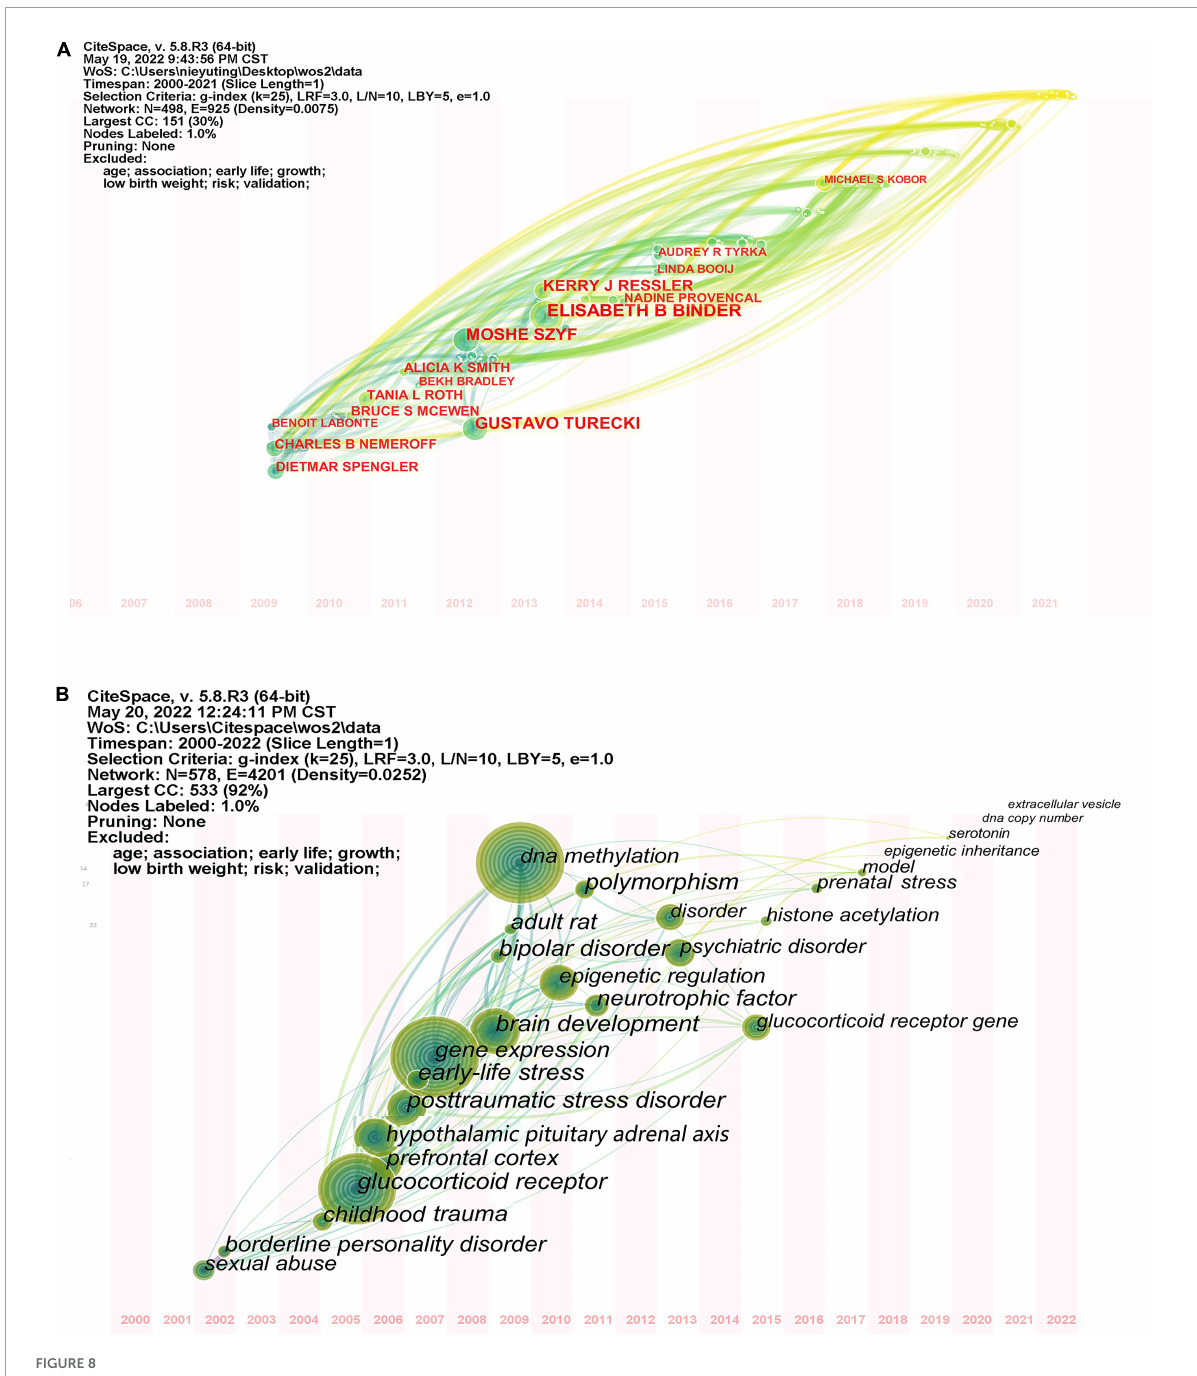
FIGURE8 (A) Author time zone atlas. (B) Keywords time zone